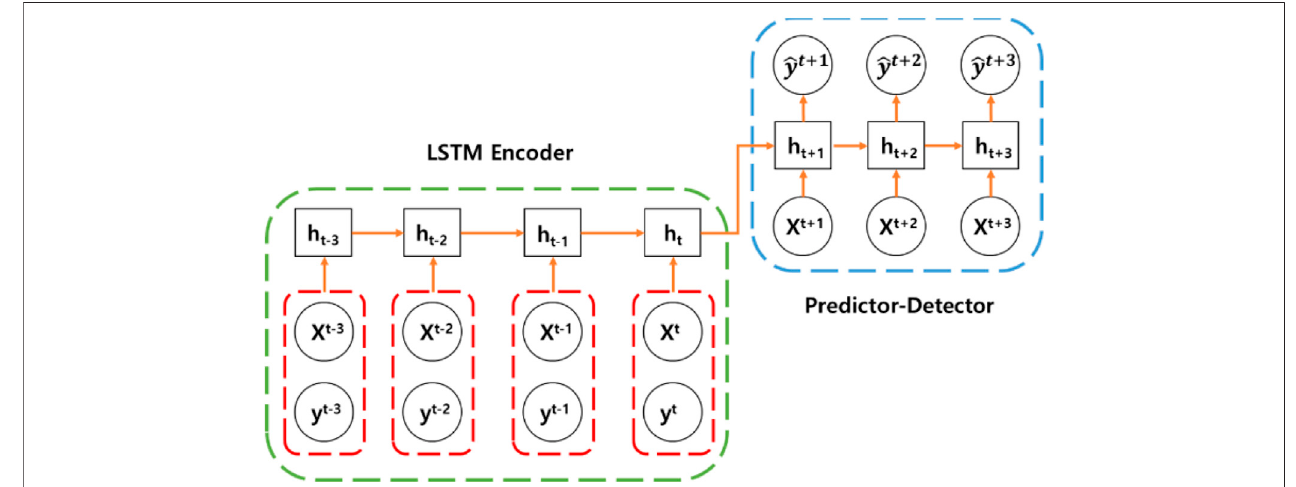
FIGURE 2 | The overall structure of QRNN.